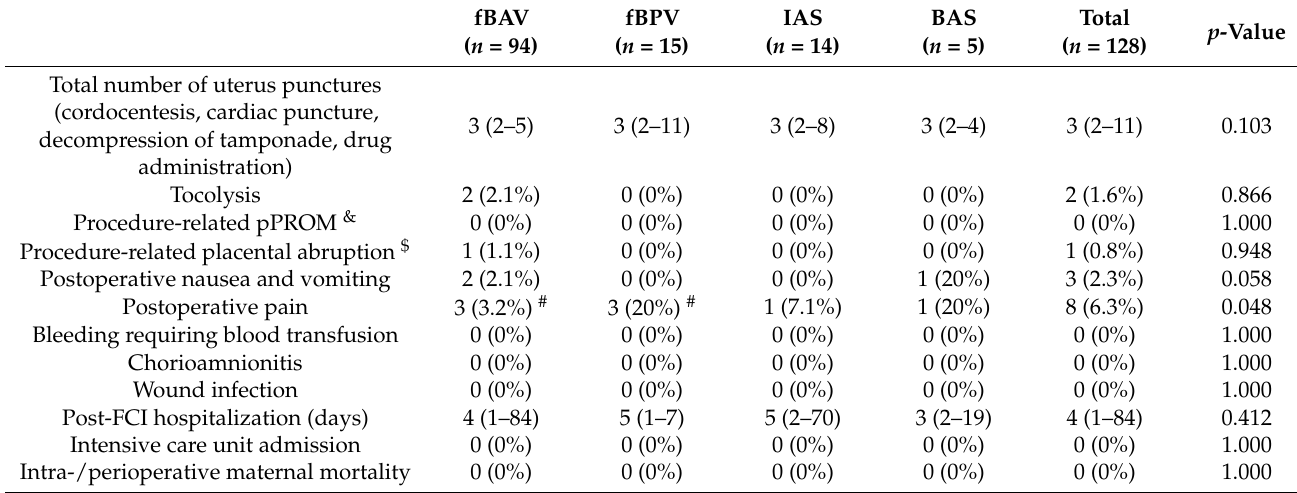
Data are given as median (range) or n (%). p -value was calculated with Kruskal-Wallis test and multiple comparisons post-hoc test. fBAV: fetal balloon aortic valvuloplasty; fBPV: fetal balloon pulmonary valvuloplasty; IAS: interatrial stent placement; BAS: balloon atrial septoplasty; & pPROM within 10 days from FCI; $ placental abruption within 10 days from FCI; # p =